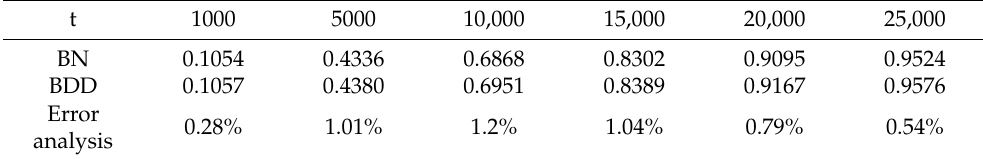
Table 4. Failure probability of automotive airbag systems under two